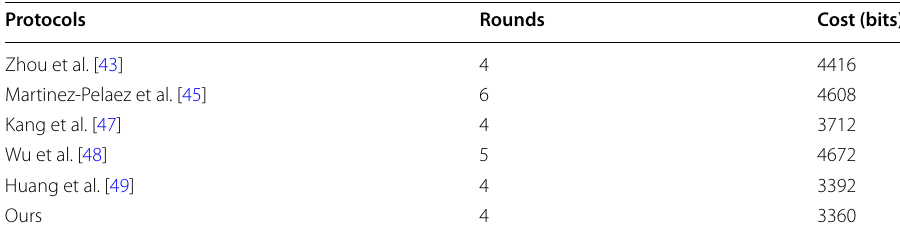
Table 7 The comparisons of communicational